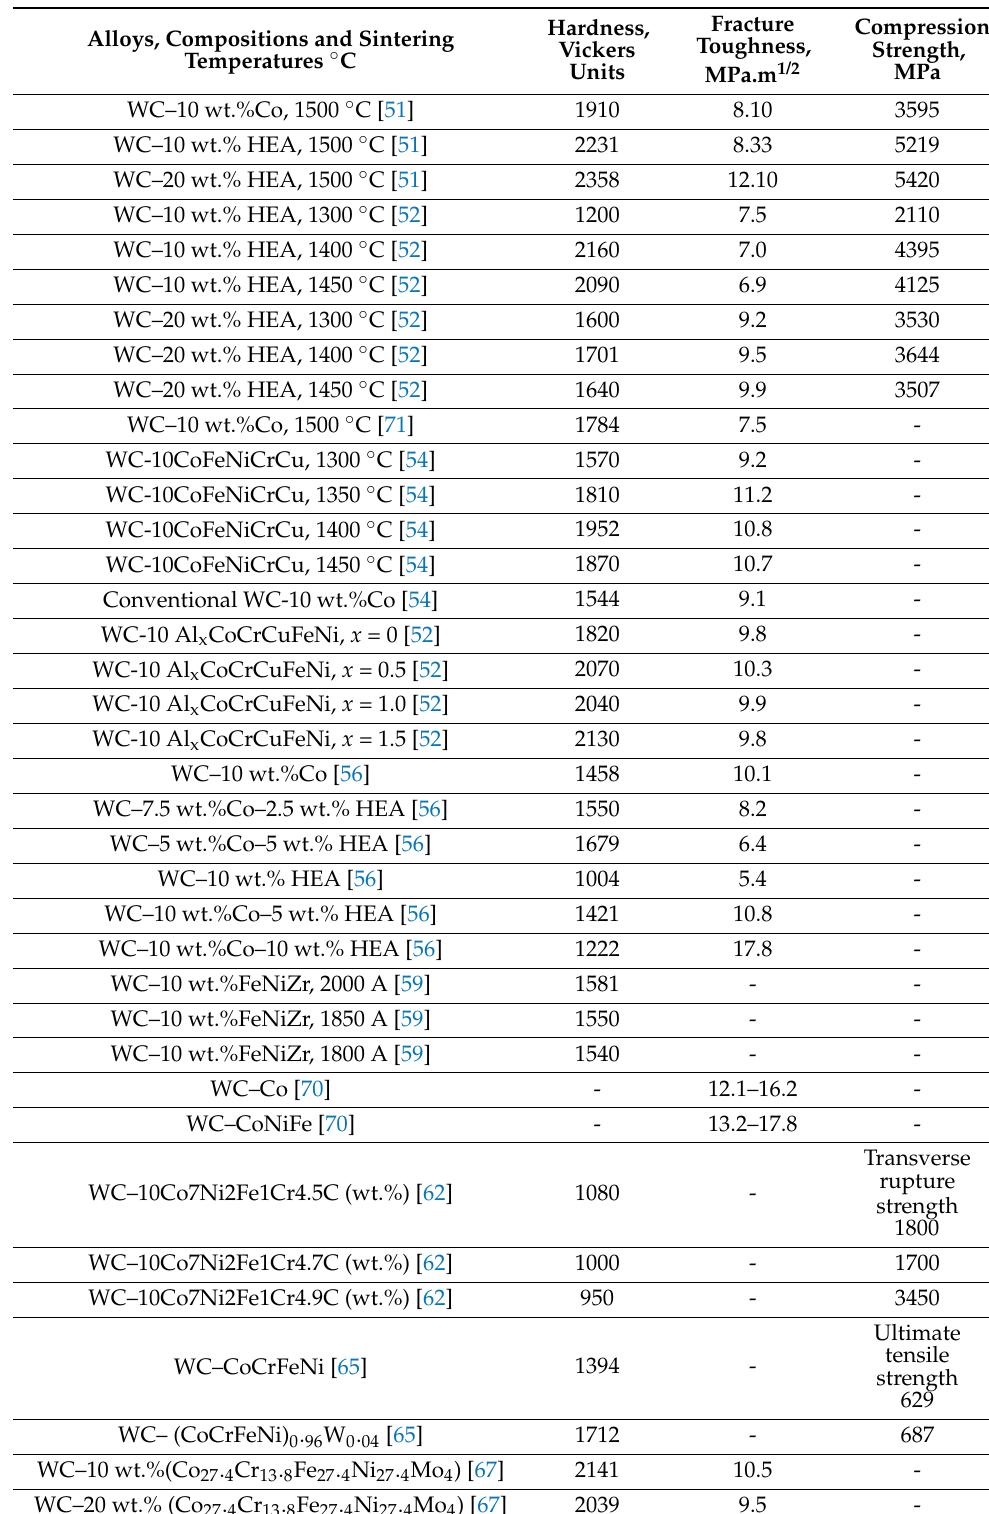
Table 3. Vickers hardness, fracture toughness, compression strength, transverse rupture strength and ultimate tensile strength of WC-based cemented carbides with Co and HEA binders. Alloys, Compositions and Sintering Temperatures ◦